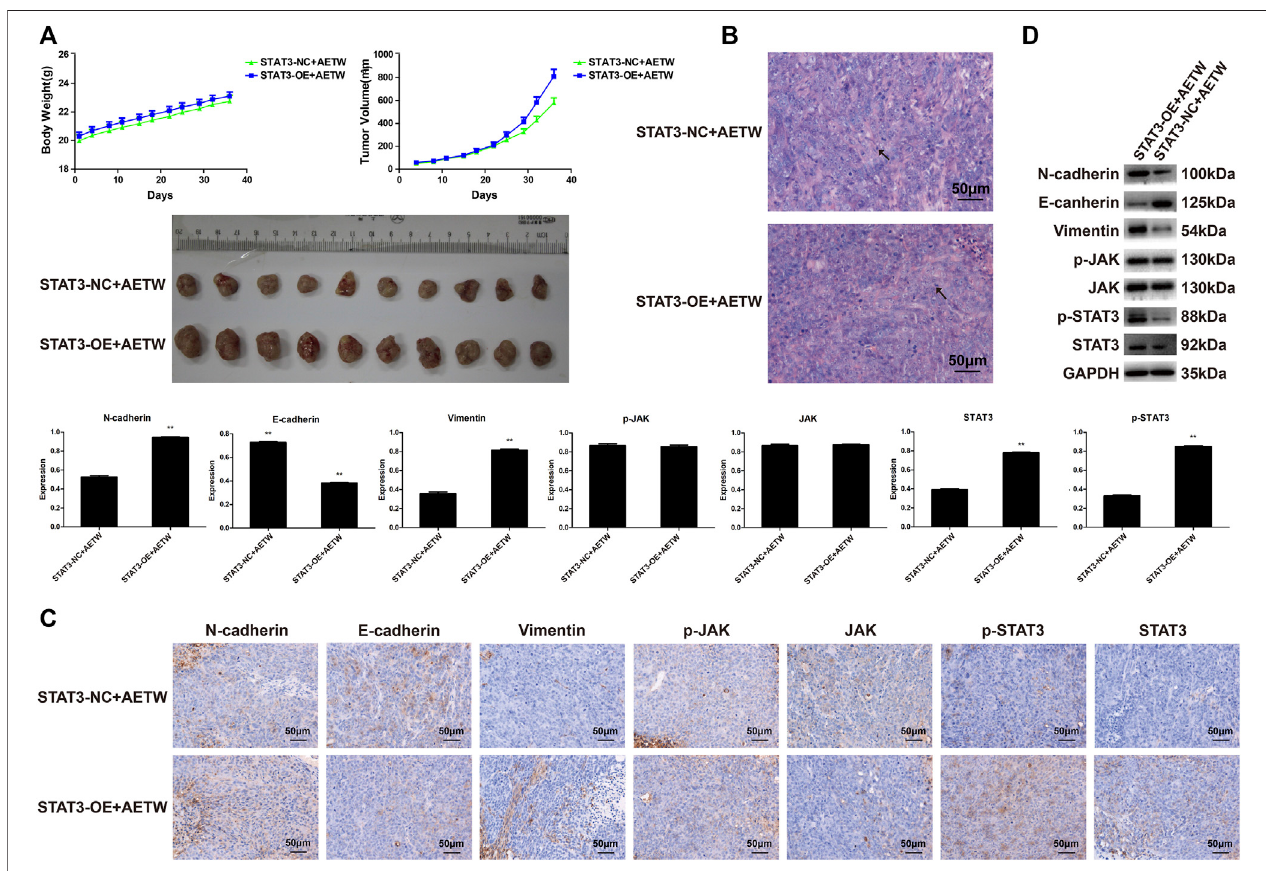
FIGURE 9 | STAT3 overexpression reversed the effect of AETW in vivo on LC tissue. (A) Measurements of tumor volume and mice body weight. (B) Hematoxylin – eosinstainingresultsoftumortissue. (C) ImmunohistochemistryanalysesofEMTmarkersand JAK/STAT3signaling regulators. (D) Westernblotanalyses of expressions of cadherins, vimentin, and JAK/STAT3 signaling proteins and their quantitative analyses. Compared with the STAT3-NC + AETW group, ** p < 0.01.